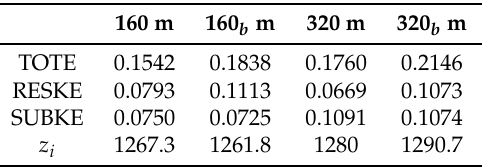
Table 5. Total kinetic energy (TOTE), resolved kinetic energy (RESKE), subgrid kinetic energy (SUBKE) and average boundary layer height ( z i ) from CBL1 simulations with 160 and 320 m grid lengths with (subscript b ) and without (no subscript)